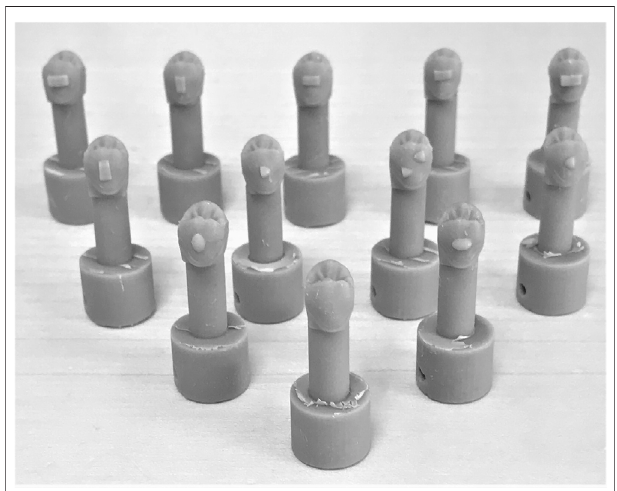
FIGURE 3 | Twelve different setups were tested consisting of eleven Invisalign ® attachments,the3Shape ® Boxattachment andonesetupwithno attachment at all serving as